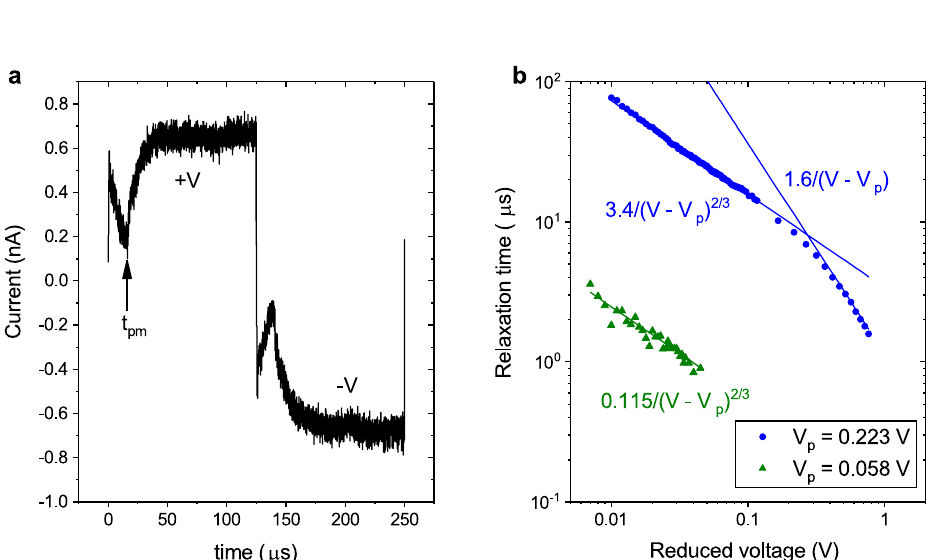
Figure 3. Relaxation response upon reversing voltage. ( a ). Characteristic dependence of current on time when a rectangular voltage pulse with amplitude ± V m and period 125 µ s is applied at temperature of 20 mK. ( b ). Scaling of local minima time t pm dependence of amplitude of rectangular voltage pulse (symbols). The solid line shows the fitting